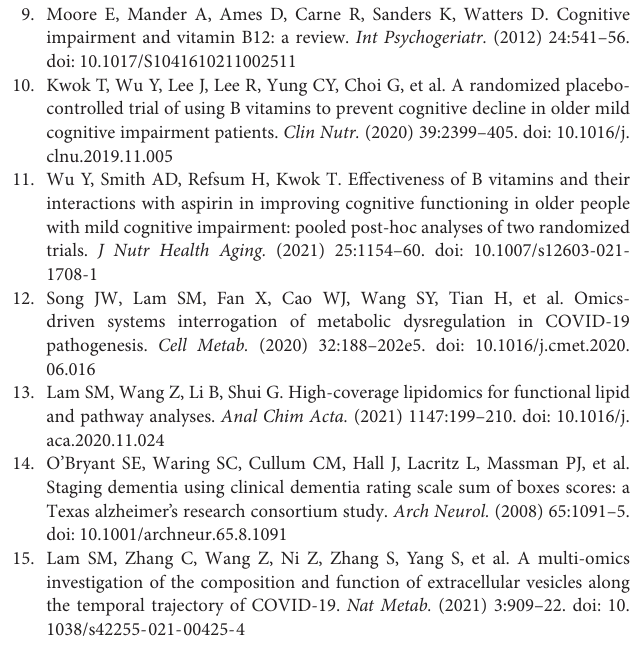
Supplementary Table 1 | Clinical information. Supplementary Table 2 | Metabolome